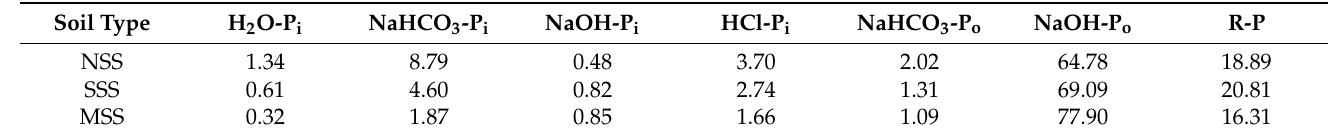
Table 2. The proportion of various forms of phosphorus in Hedley under different soil salin- ity